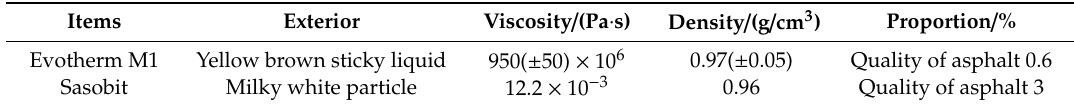
Table 2. Properties of warm mix additives.